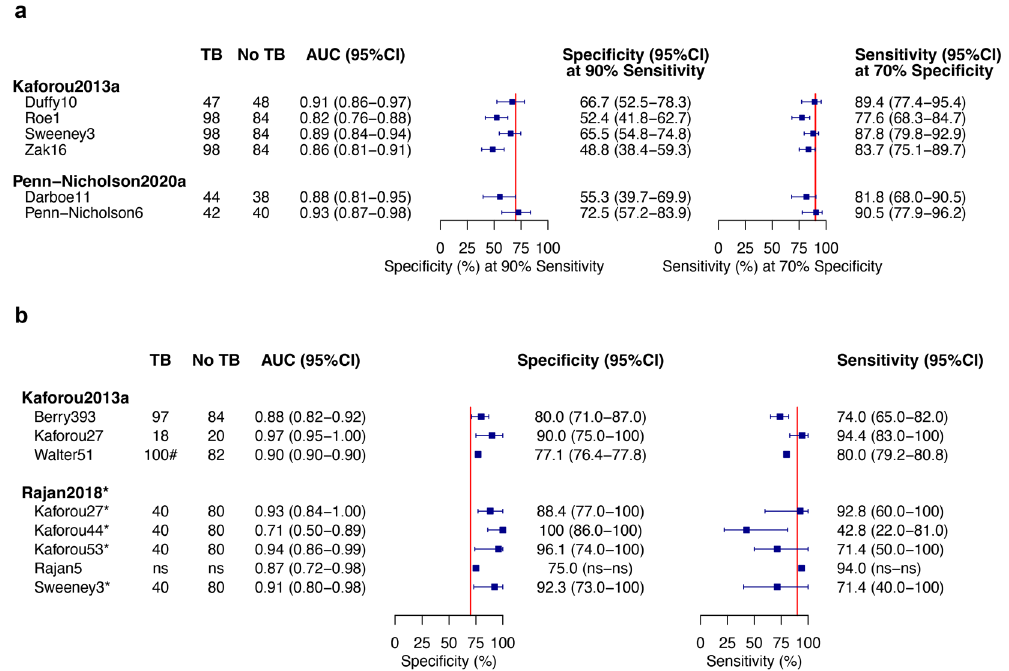
Figure 3. Transcriptomic signature diagnostic performance for differentiation of patients with microbiologically confirmed TB disease from latent-Mtb infected individuals or healthy controls in independent test or external validation cohorts. ( a ) Signature diagnostic performance (area under the curve, AUC) recalculated using participant-level data retrieved from supplementary data or supplied by study authors, with sensitivity and specificity benchmarked against the WHO TPP minimum performance criteria for a triage test (70% specificity and 90% sensitivity, red vertical lines) 16 . 95% confidence intervals for AUC and proportions (sensitivity and specificity) were calculated using the DeLong 30 and binomial proportion (Wilson) 31 methods, respectively. ( b ) Signature diagnostic performance